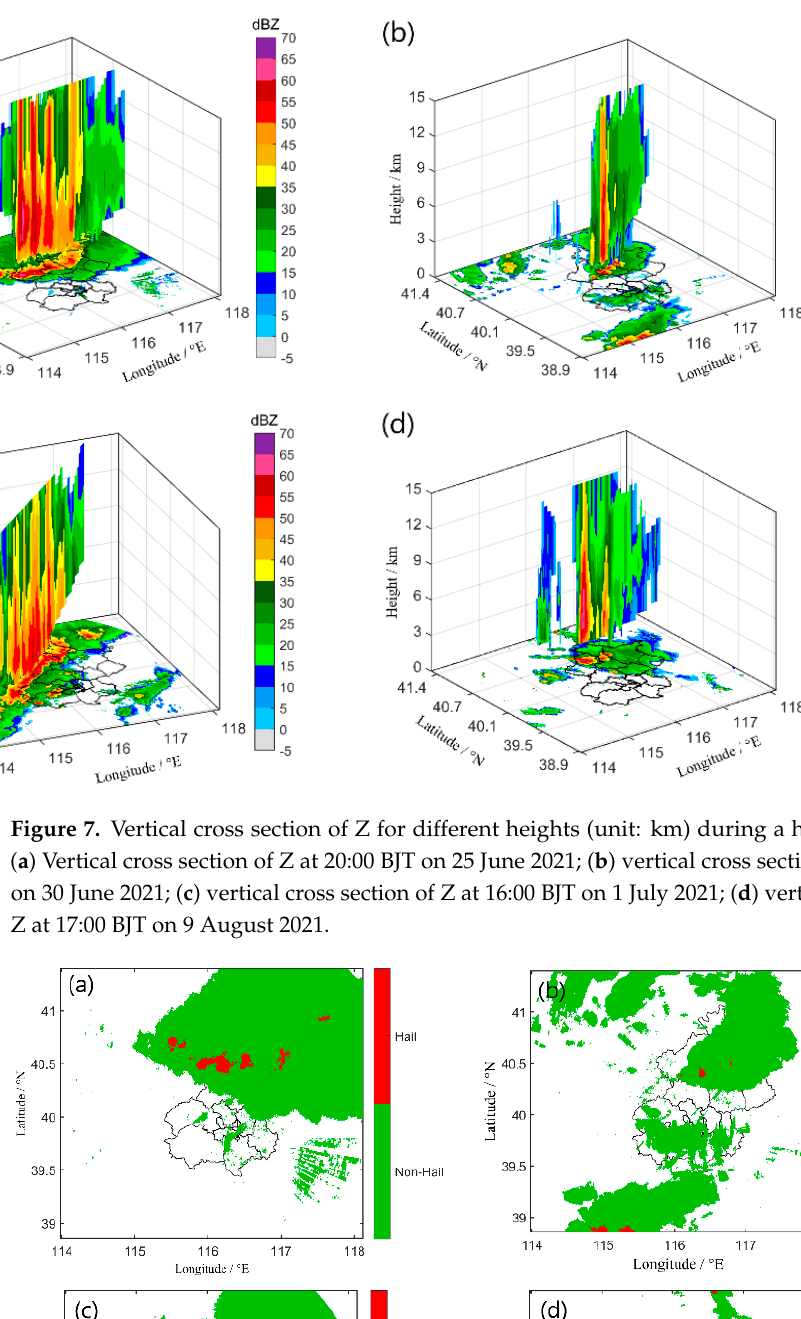
Figure 6. Composited S-band radar reflectivity factor Z (unit: dBZ) in Beijing. ( a ) Z at 20:00 BJT on 25 June 2021; ( b ) Z at 16:00 BJT on 30 June 2021; ( c ) Z at 16:00 BJT on 1 July 2021; ( d ) Z at 17:00 BJT on 9 August 2021.